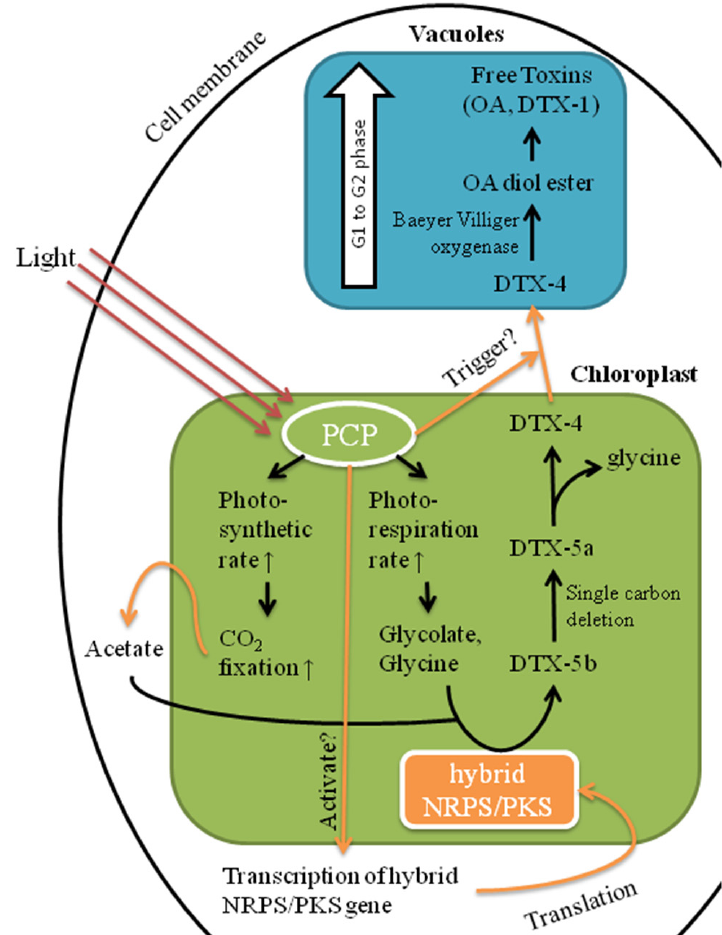
Figure 5. The possible pathway of DSP toxin biosynthesis and the role of peridinin chlorophyll a binding protein (PCP) and hybrid NRPS/PKS. Orange arrows indicate possible pathways suggested by this study while black arrows indicate demonstrated pathways according to the literature.